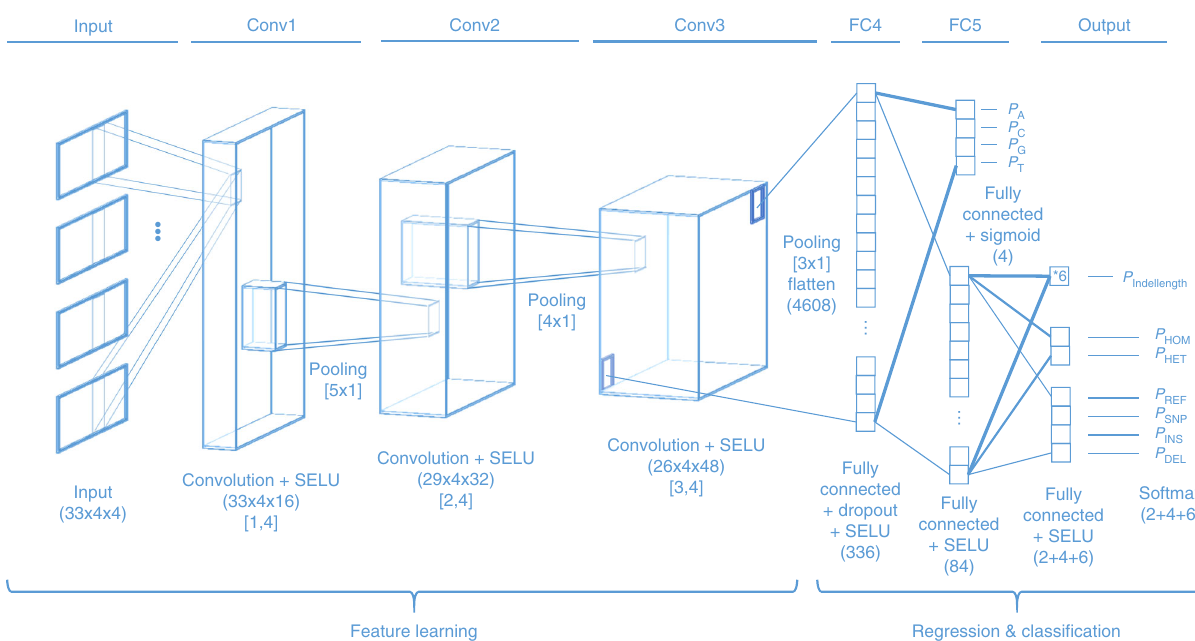
Fig. 3 Clairvoyante network architecture and layer details. The descriptions under each layer, include (1) the layer ’ s function; (2) the activation function used; (3) the dimension of the layer in parenthesis (input layer: height × width × arrays, convolution layer: height× width × fi lters, fully connected layer: nodes), and (4) kernel size in brackets (height ×